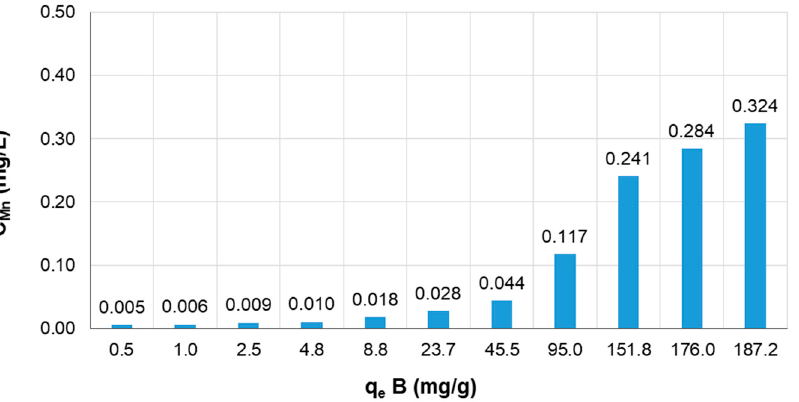
Figure 10. The influence of the sorption capacity of boron on the elution of manganese ions from the Mn-biosorbent hydrogel beads. Initial boron concentration C 0 = 100–5000 mg/L; biosorbent dose 1 g/20 mL; temperature 20 °C; contact time 2 h.